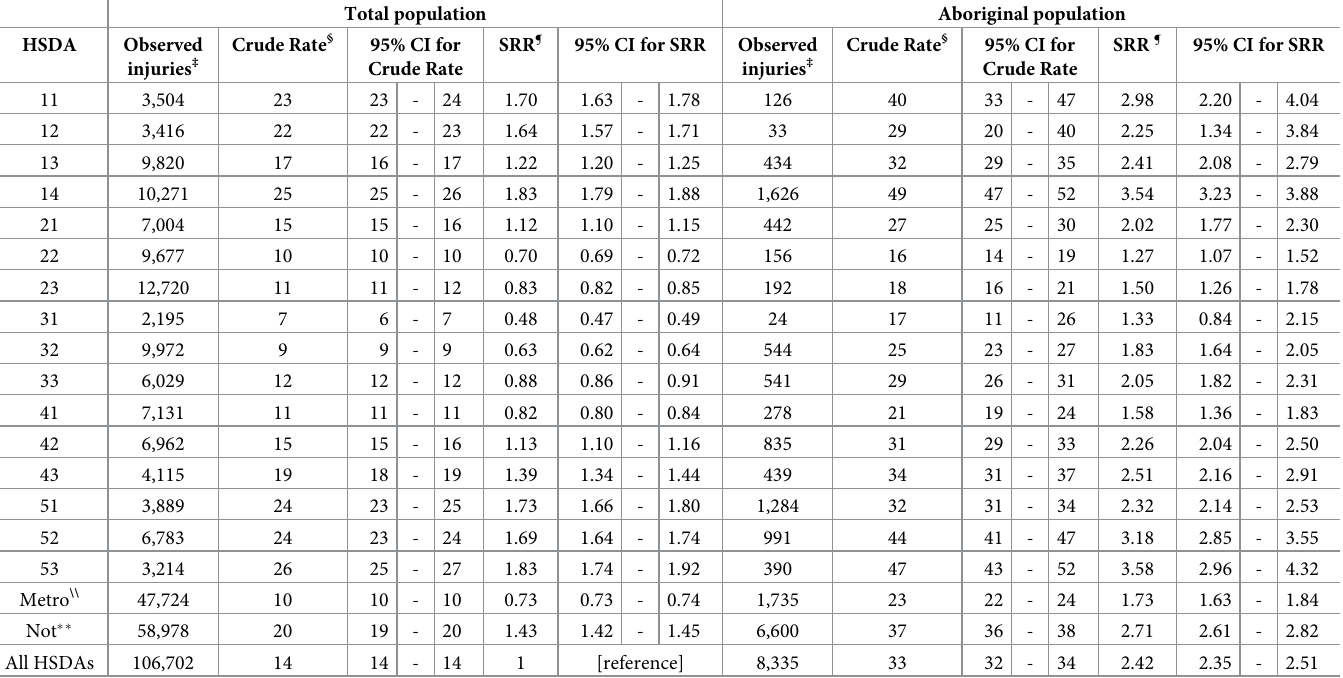
Table 2. Hospital separations for unintentional transport injuries (cid:3) , British Columbia, 1991–2010†, by Health Service Delivery